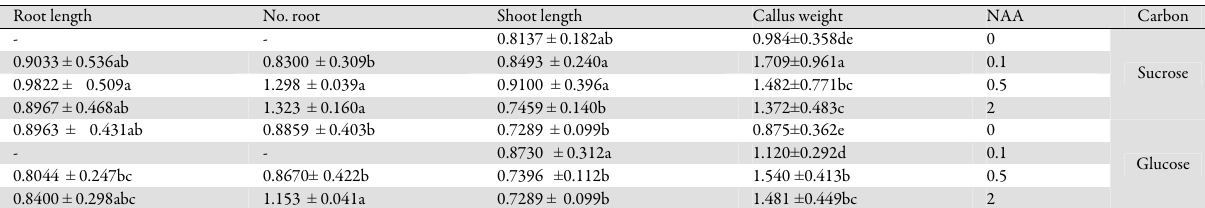
Table 9. The effect of NAA and carbon sources on callus, shoot and root induction of A . annua on MS medium Root length